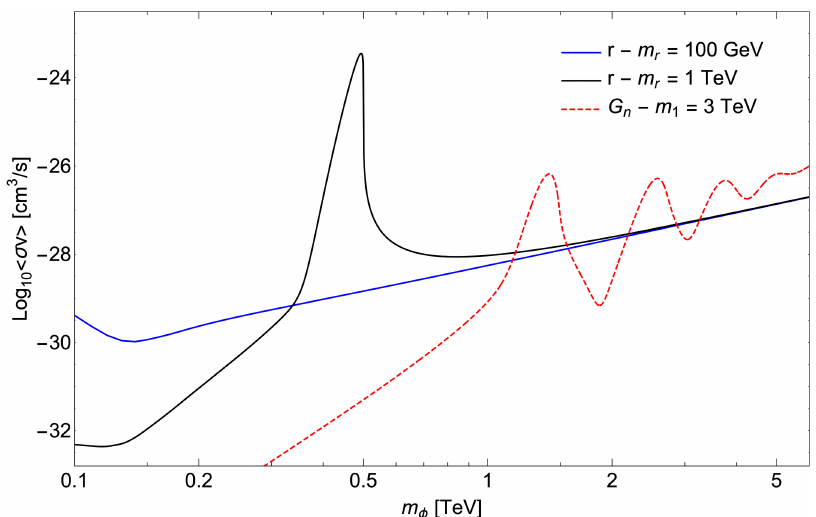
Figure 3 . Thermally averaged annihilation cross section into SM final states as a function of the DM mass. We choose m 1 = 3 TeV and Λ = 8 TeV. The contribution from KK-graviton exchange is shown in red (dashed). For the radion we show two representative choices of the radion mass, m r = 100 GeV and m r = 1 TeV in blue (solid) and black (solid), respectively. We fixed the temperature to T = m φ / 20 which is in the ballpark of the typical freeze-out